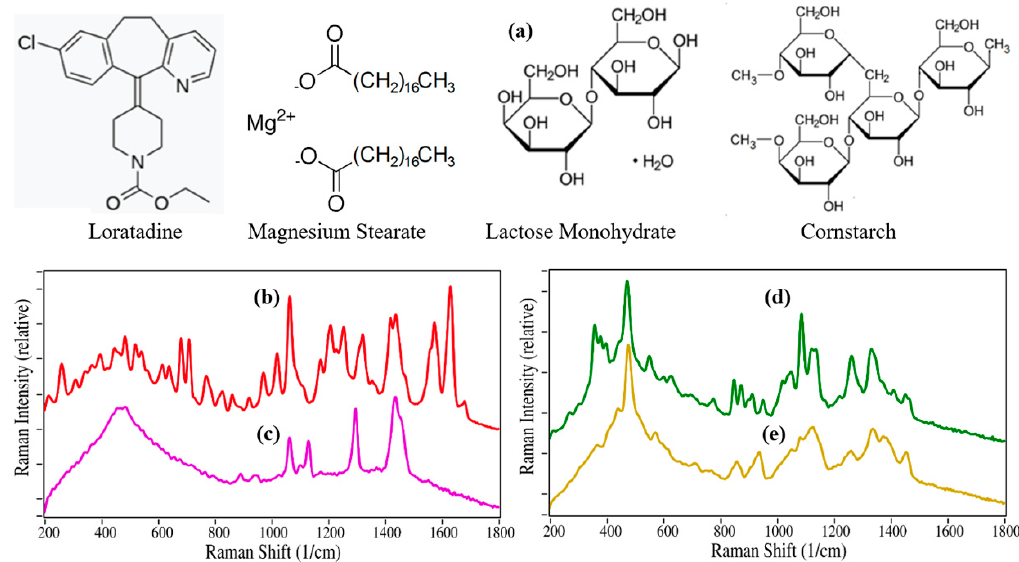
Figure 1. ( a ) Chemical structures for all four Claritin chemicals. Raman spectra of ( b ) loratadine, ( c ) magnesium stearate, ( d ) lactose monohydrate, and ( e ) cornstarch. Sample conditions: Tablets (pressed at 1500 psi). Spectral Conditions: 275 mW at 1064 nm, 10 averaged, 2-s integration scans/spectrum (total time was 200 s).